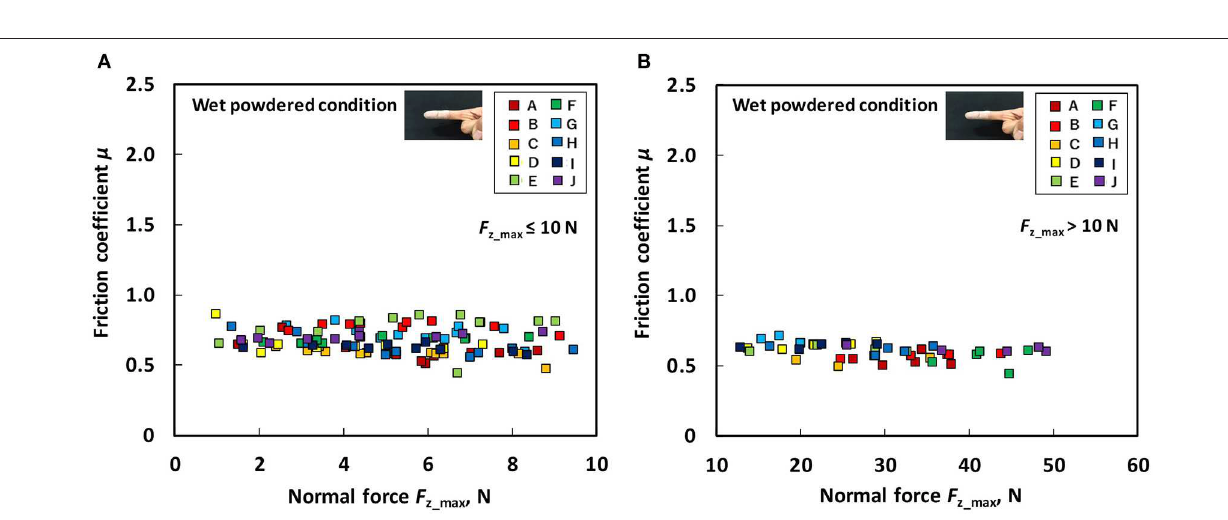
FIGURE 7 | Relation between normal force ( F z_max ) and friction coefficient ( µ ) under the wet powdered condition (A) during low normal force condition ( F z_max ≤ 10N) and (B) during large normal force condition ( F z_max >